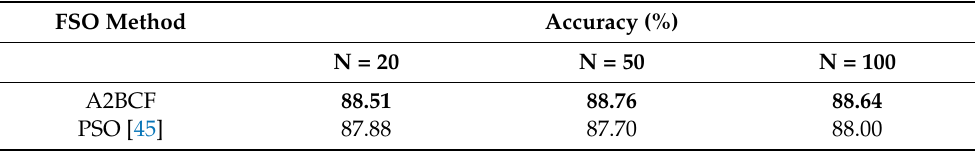
Table 2. Comparison of A2BCF and PSO feature selection